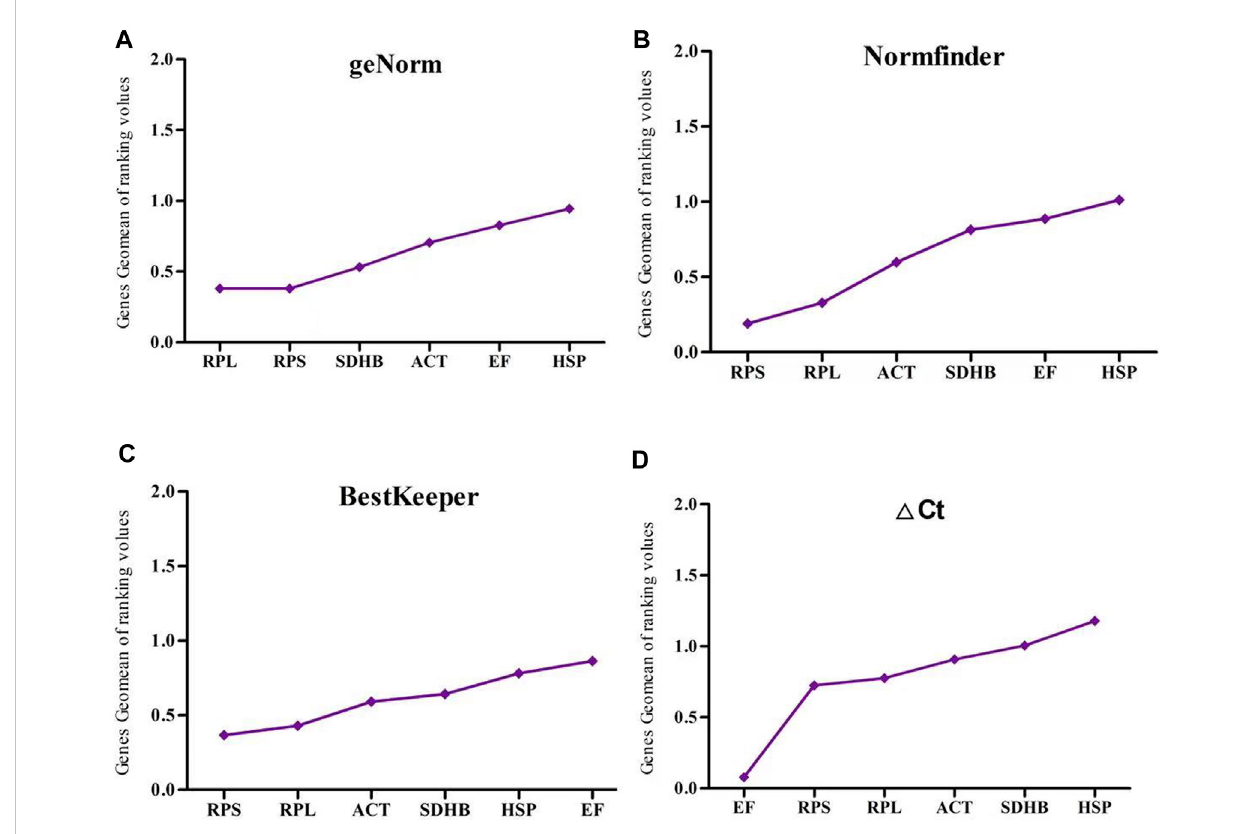
FIGURE 4 The stability of six reference gene different insecticide treatment samples of Megalurothrips usitatus genescalculated by the Geomean method of RefFinder. (A) , geNorm; (B) , NormFinder; (C) , BestKeeper; (D) , Δ Ct.